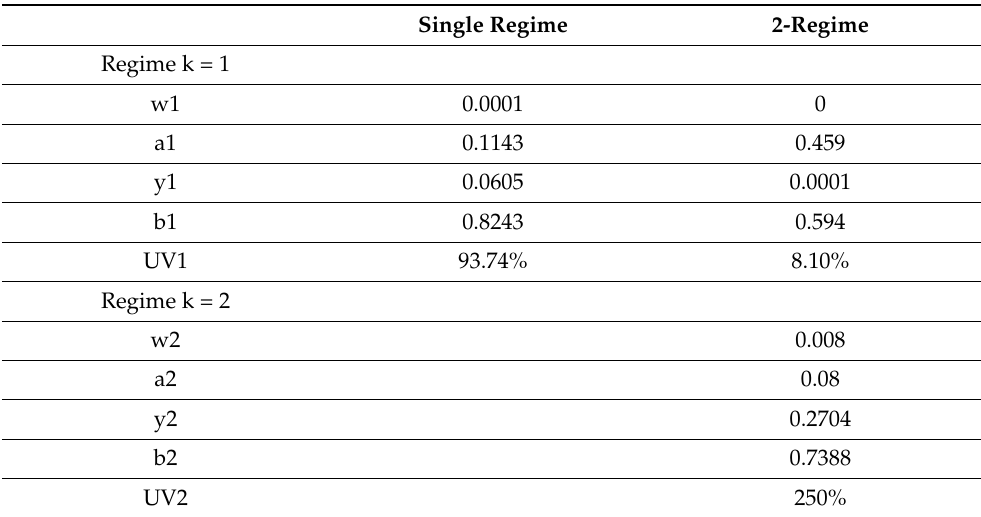
Table 9. Parameter Estimate.